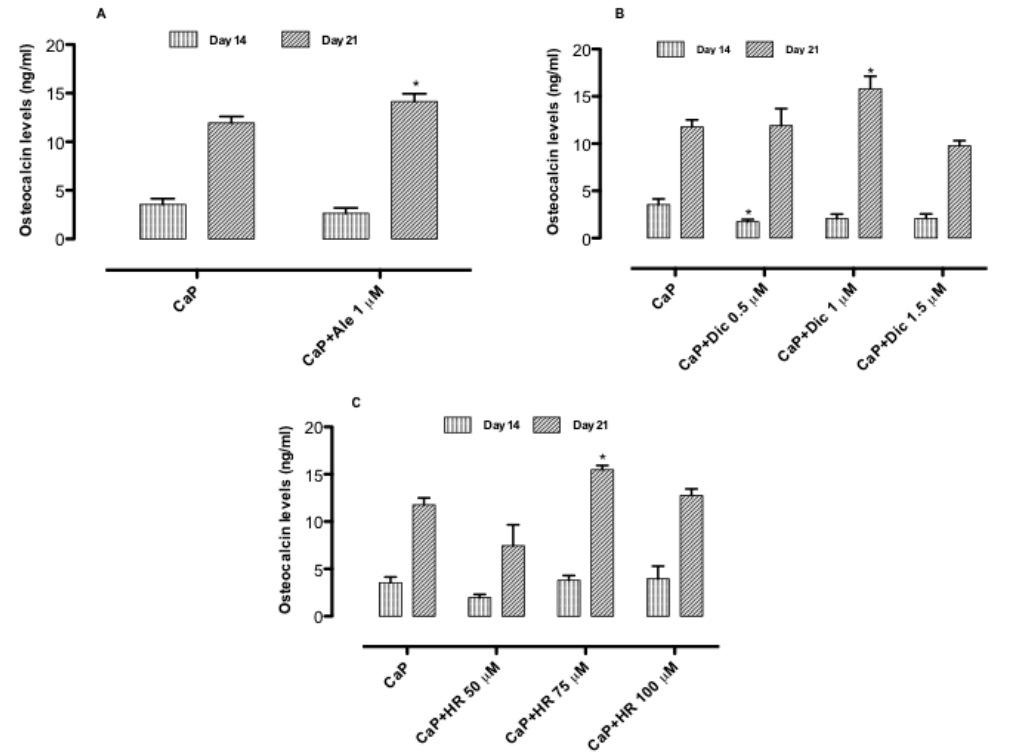
Figure 5. Osteocalcin levels of osteoblasts seeded onto CaP alone and CaP + Ale ( A ), CaP + Dic ( B ), CaP + HR ( C ) in basal medium at days 14 and 21. Data represent mean ± dev.st. of three independent experiments ( n = 6). * p < 0.05 vs. CaP.